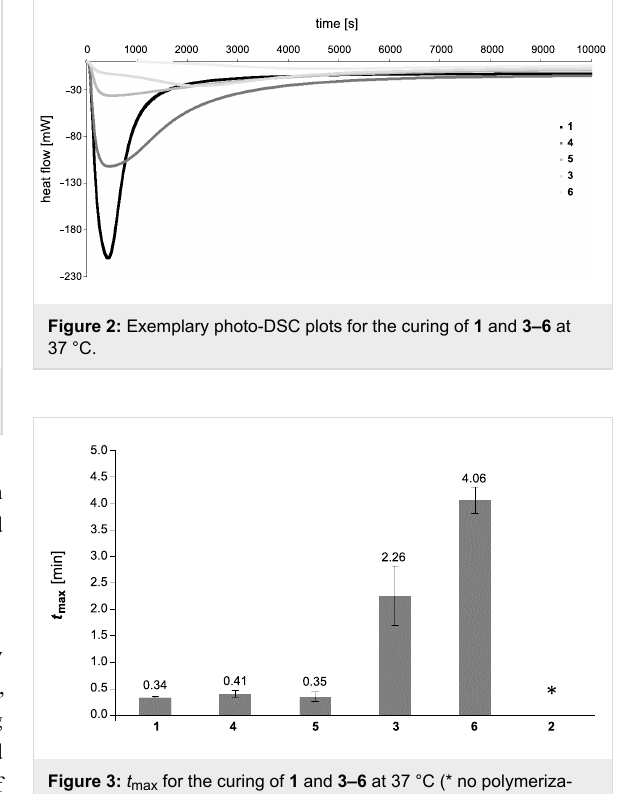
Figure 3: t max for the curing of 1 and 3–6 at 37 °C (* no polymeriza- tion heat